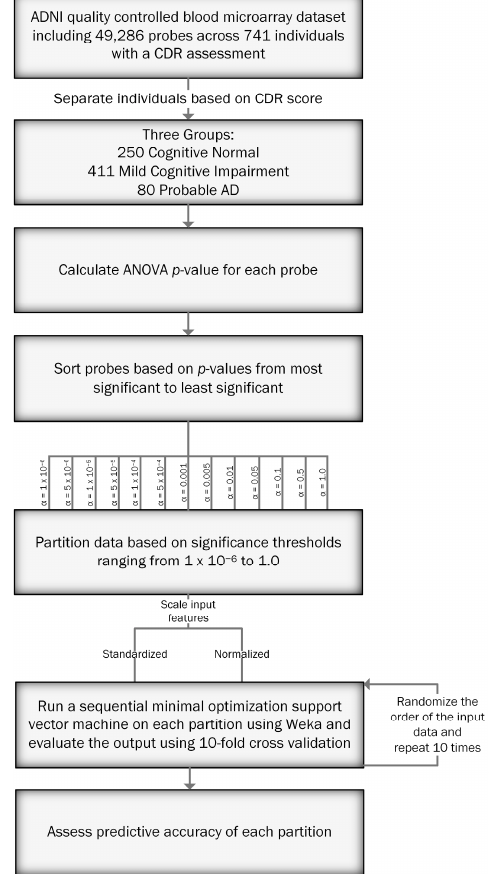
Figure 1. Flowchart depicting the analysis process to predict cognitive status using the ADNI blood microarray dataset.